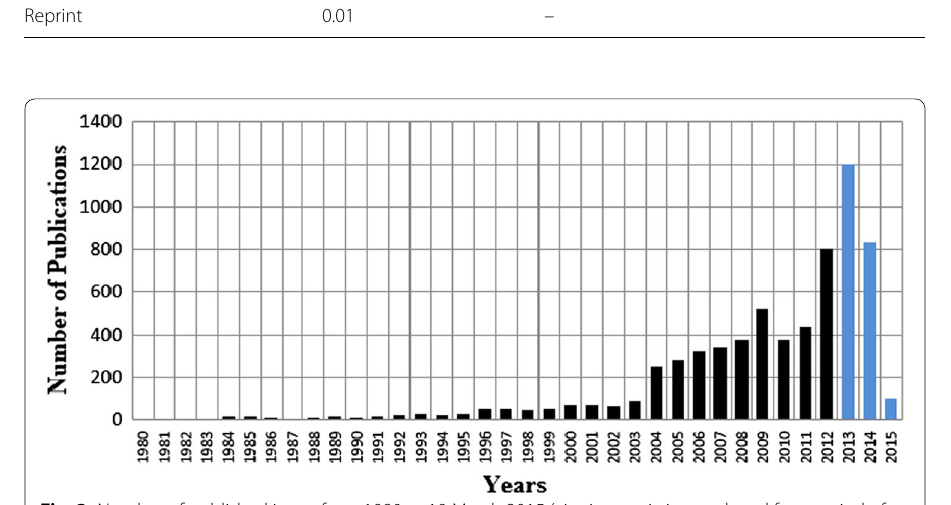
Fig. 3 Number of published items from 1980 to 19 March 2015 (citation statistics produced for a period of less than 3 years may not be sufficiently stable, as indicated in blue color bars)